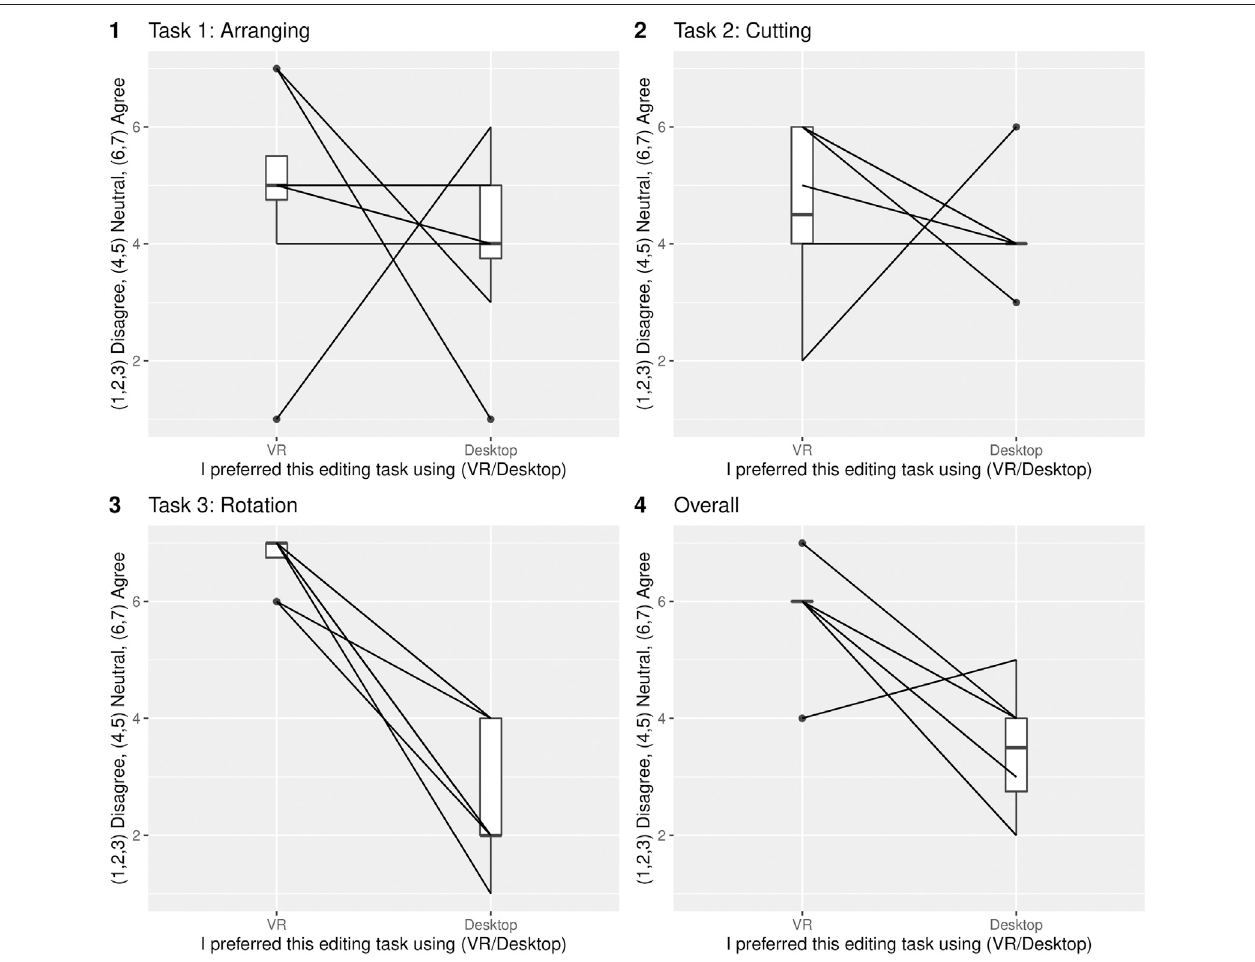
FIGURE15| Pairedresponsestothe fi nalquestionnairefortheVRandDesktopconditions.Mostparticipantsagreewiththeirresponses.However,thereareafew exceptions such as in the arranging task. Here, one participant strongly preferred VR and another participant preferred the Desktop option.